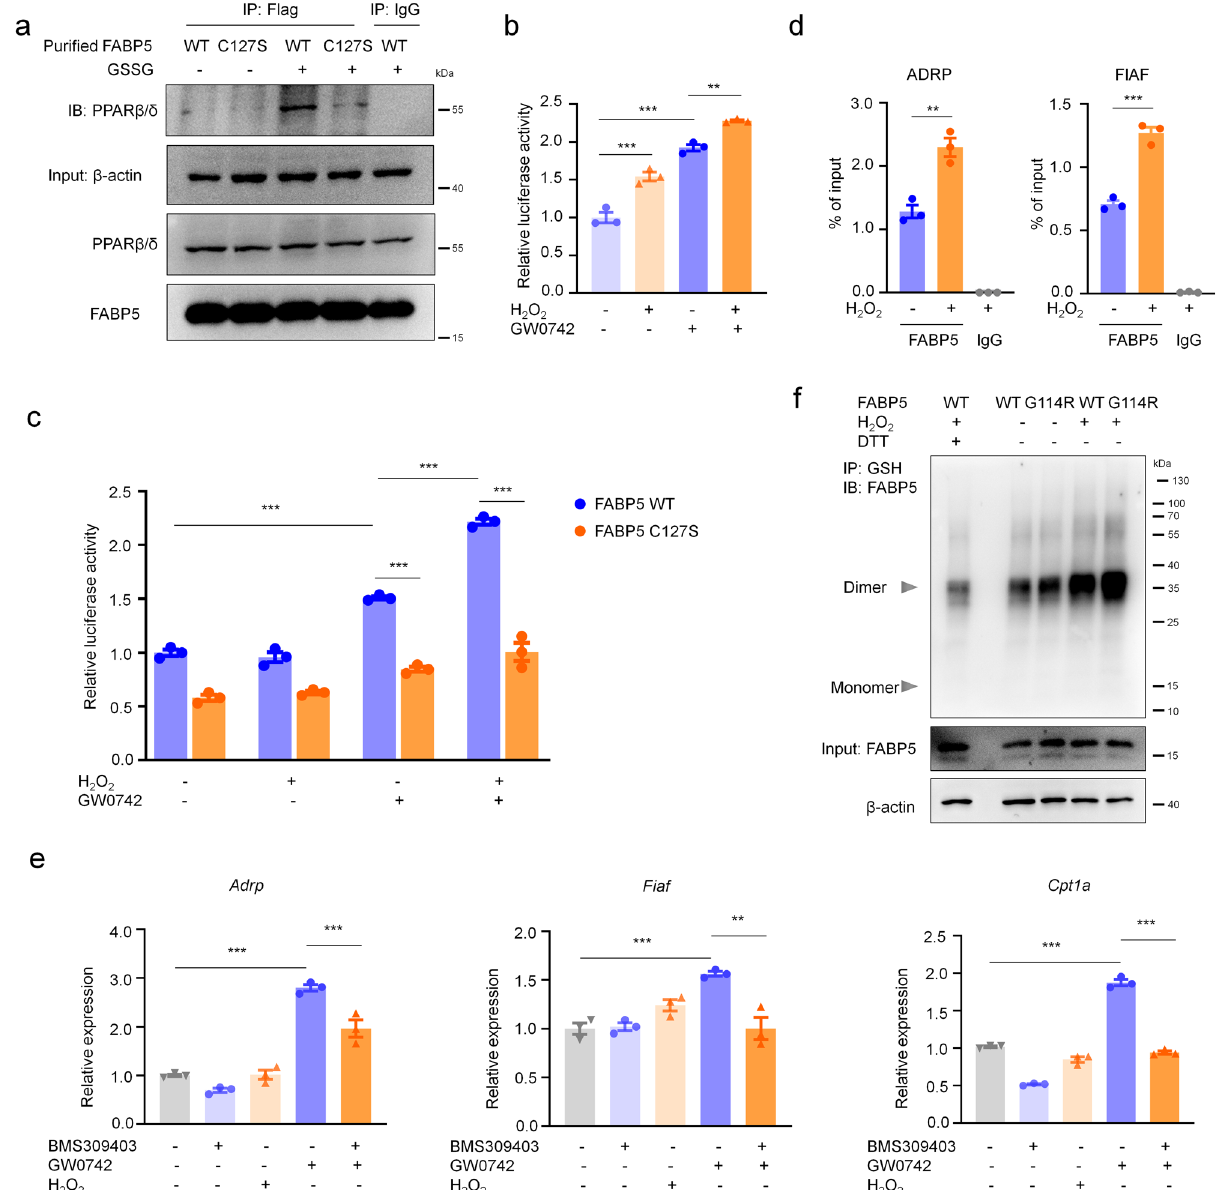
Fig. 8 FABP5 S-glutathionylation controls macrophage in fl ammation by activating PPAR β / δ . a In vitro pull-down assays. The mouse recombinant FABP5 (WT or C127S) protein with 3xFlag tag puri fi ed from E. coli treated with GSSG (1 mM) for 15 min was incubated with COS-7 lysates and precipitated with Flag-magnetic beads, respectively. Precipitates were subjected to SDSPAGE and examined by immunoblot with anti PPAR β / δ antibodies. b Transactivation assays in Raw264.7 cells transfected with a PPRE-driven luciferase reporter. After nucleofection with PPRE X3-TK-luc and pRL-TK, Raw264.7 cells were serum starved for 8 h, then exposed to H 2 O 2 (200 μ M), GW0742 (1 μ M), or both for 24 h, and luciferase activity was determined, n = 3 in each group,